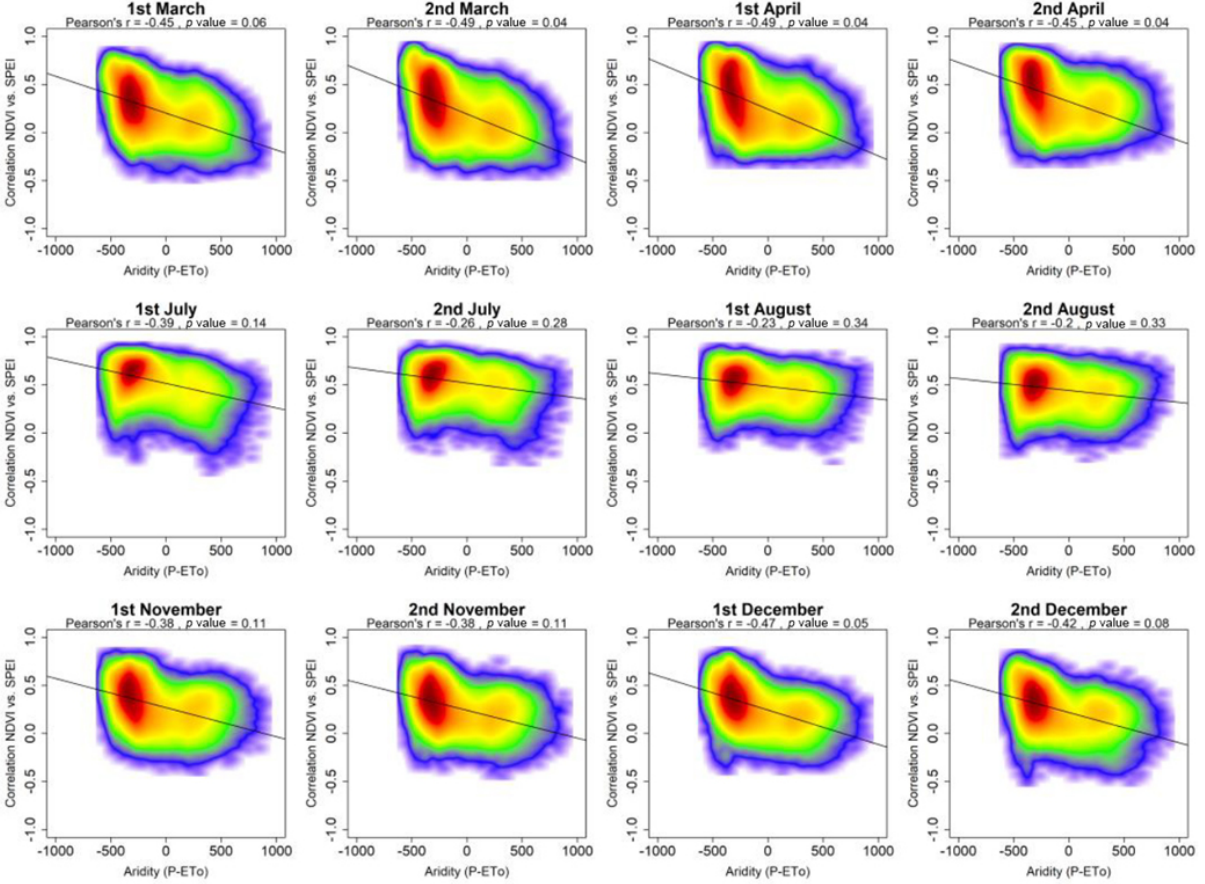
Figure 8. Scatterplots showing the relationships between the maximum correlation obtained between the sNDVI and the SPEI and the climate aridity (precipitation minus ETo). Given the high number of data, the significance of the correlation was obtained using a bootstrap method. A total of 1000 random samples of 30 data points each were extracted, from which correlations and p values were obtained. The final significance was assessed by means of the average of the obtained correlation coefficients and p values, which are indicated in the